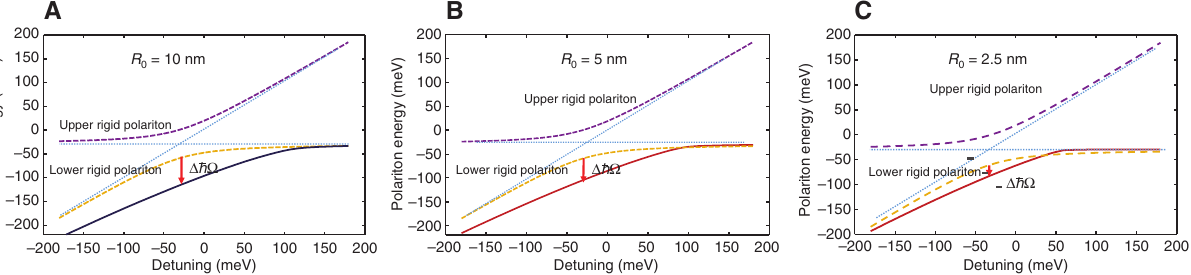
Figure 6: Lower polariton dispersion versus the energy of the “undressed” surface plasmon relative to the bandgap energy for three different radii of the Ag nanosphere.